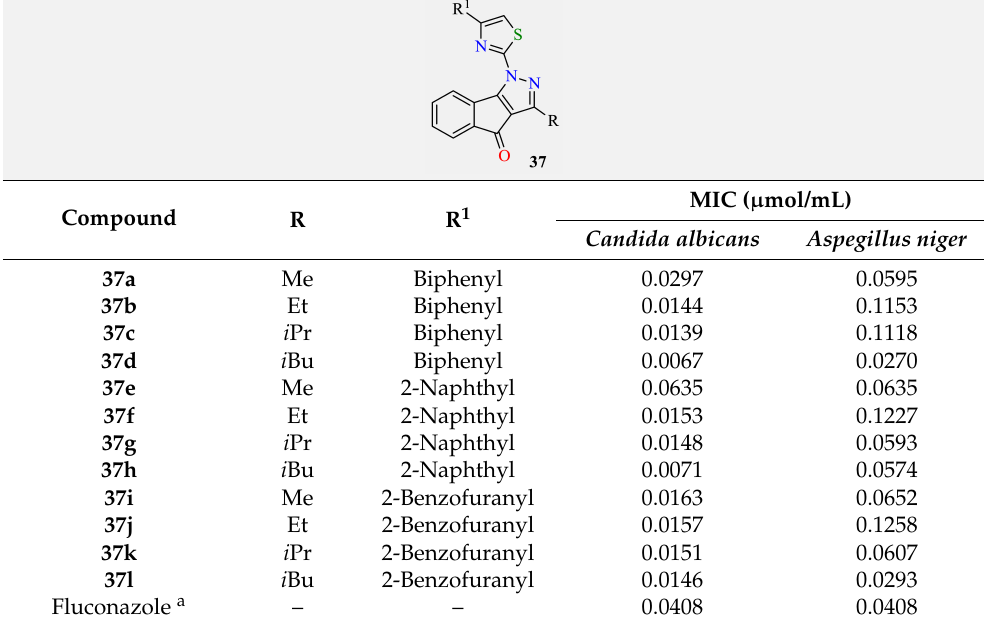
Table 43. Antifungal activity of 3-alkyl-1-(4-(aryl/heteroaryl)thiazol-2-yl)indeno[1,2- c ]pyrazol-4(1 H )- ones 37